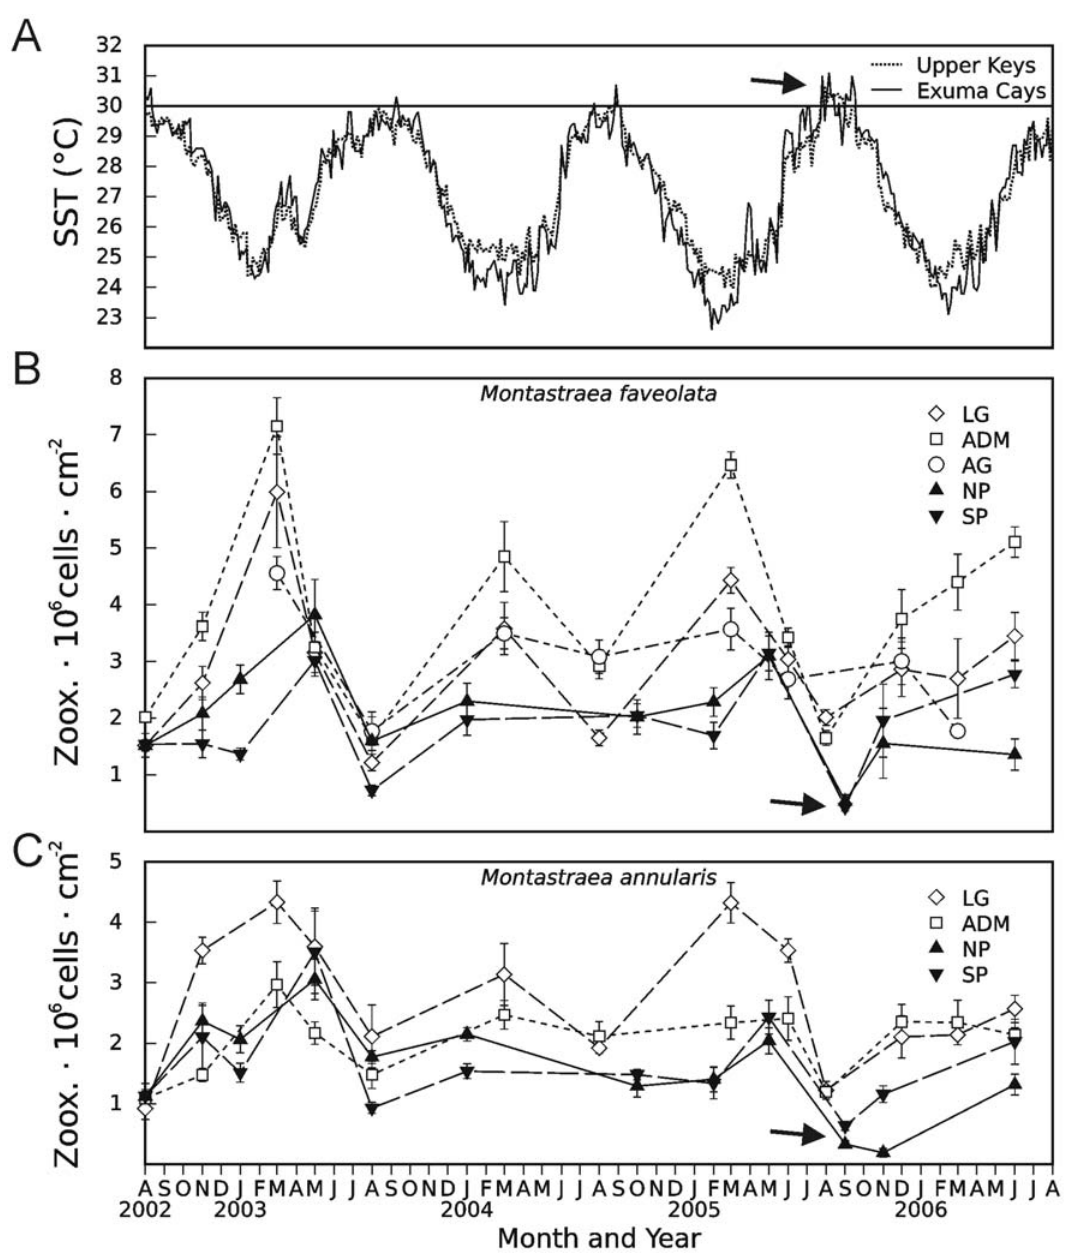
Figure 3. Sea-surface temperatures and Symbiodinium cell densities from Montastraea spp. corals. Nocturnal sea-surface temperatures (A) in the Upper Florida Keys (U.S.) and Exuma Cays (Bahamas) between August 2002 and August 2006. Solid line demarcates the approximate ‘high- temperature bleaching threshold’ of 30 u C, while an arrow notes the increased frequency of temperatures above 30 u C in 2005 relative to preceding years. Symbiodinium cell densities in tagged colonies of Montastraea faveolata (B) and M. annularis (C) from the five collection sites, three in the Upper Florida Keys (white markers) and two in Exuma Cays (black markers). Cell density data are expressed as means 6 SE. Arrows denote decreased symbiont cell densities correlated with the high-temperature bleaching event in the Exuma